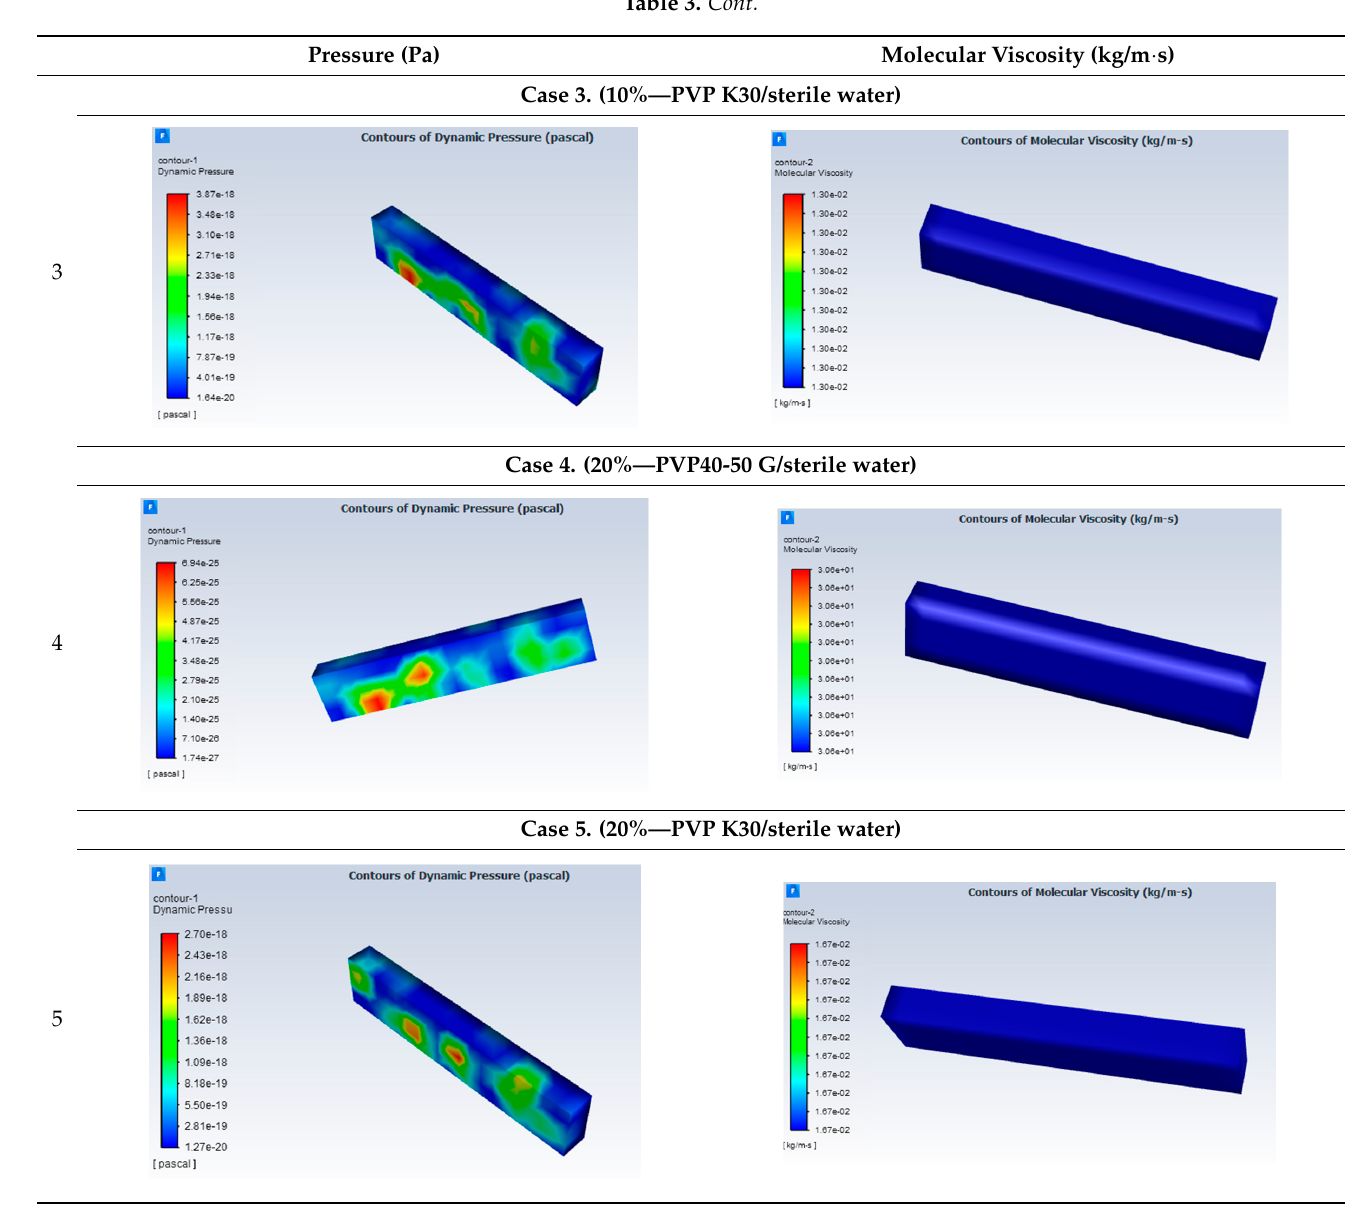
Table 4. Pressure and molecular viscosity values in each of the